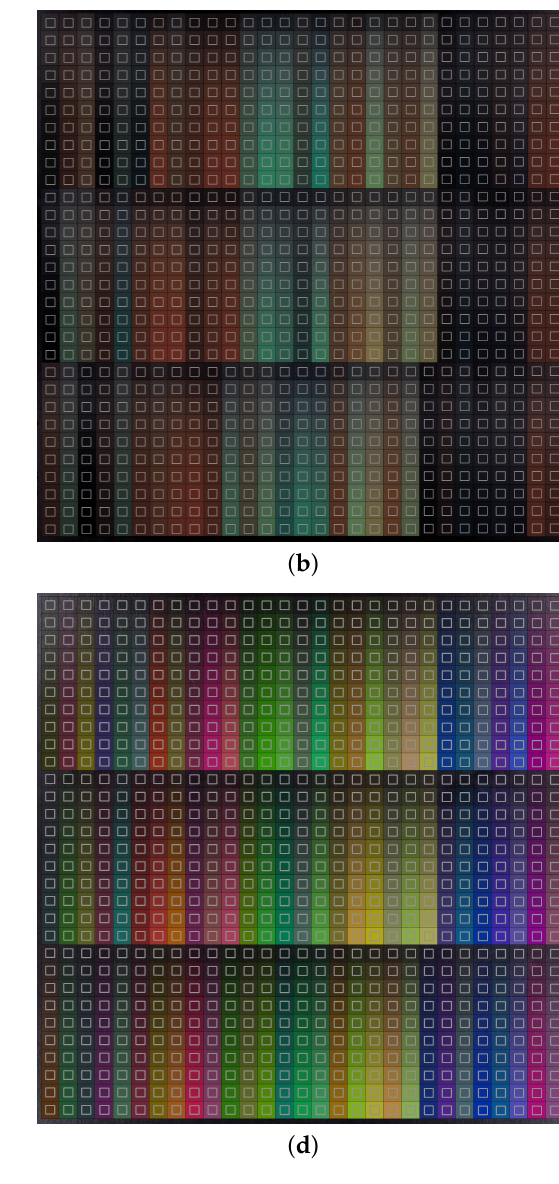
Figure 5. Averaged effective colours extracted from the sample grid in Figure 2 printed with 20 pl ( a ) and 10 pl ( b ) on clear glass, and with 10 pl on satinated glass ( c ). The corresponding effective nominal colours are shown in ( d ). Note that these images include the superimposed ROIs from the extraction script, and are equalised for